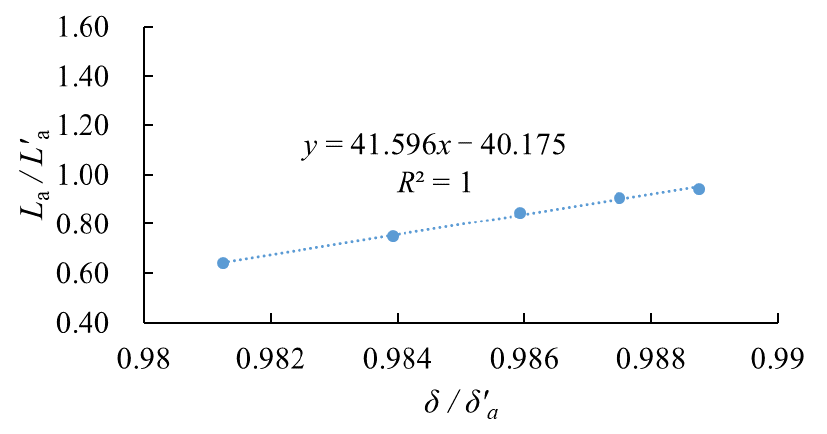
Figure 21. The relationship between L a / L’ a and δ / δ’ a when groin B is in the downstream far-field of groin A.